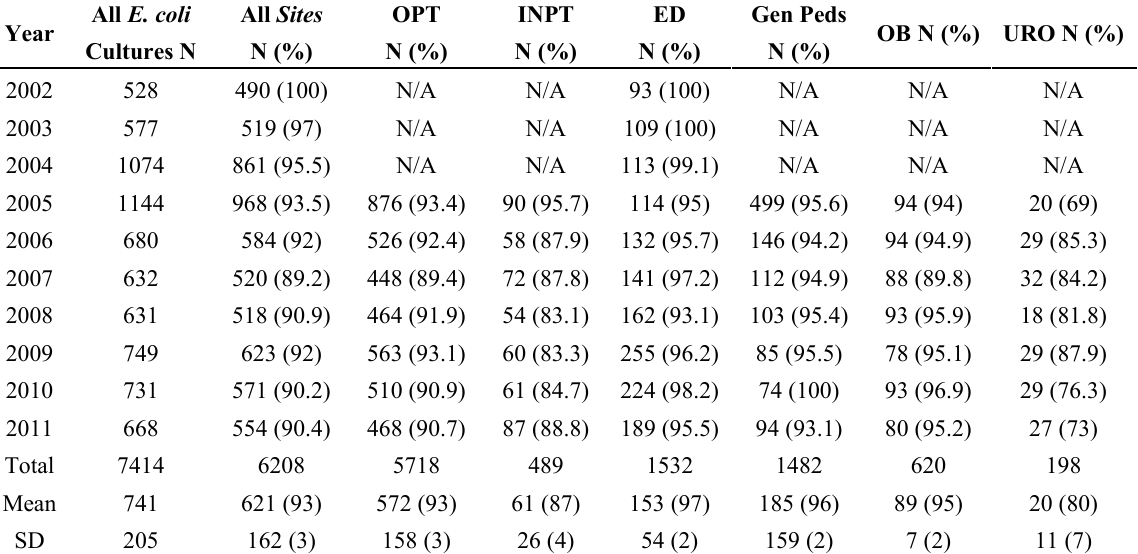
Table 3. Ciprofloxacin susceptibilities of pediatric E. coli positive urinary cultures by site (N = number, OPT = outpatient, INPT = inpatient, ED = emergency department, Gen Peds = general pediatrics, OB = obstetrics, URO = urology).